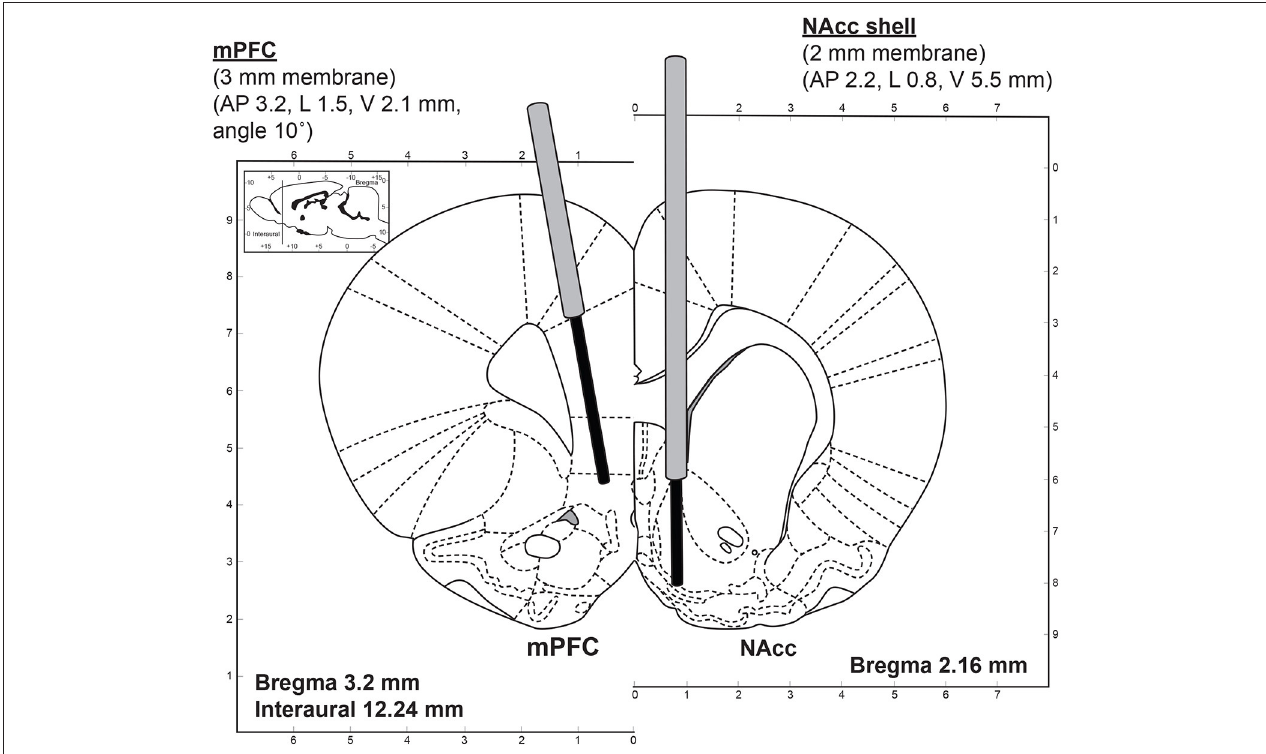
FIGURE 1 | Dual-probe microdialysis—an illustration of the stereotaxic placement of the microdialysis probes into the mPFC (3mm membrane length) and nAcc shell (2mm membrane length) at coordinates determined using the rat brain atlas ( 35).